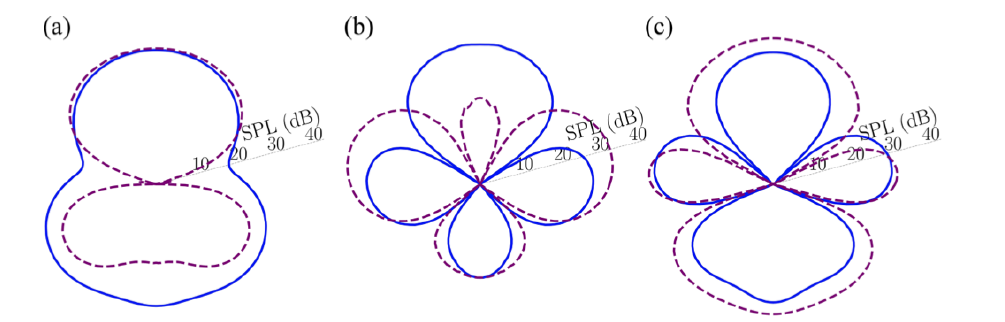
Figure 5. Evolution of the sound pressure level, on two different far-field planes, at three time instances during reconnection [100]. The directivity of the sound pressure level are shown at the start ( a ), end ( b ), and a long time after reconnection ( c ). Reprinted with permission from American Physical